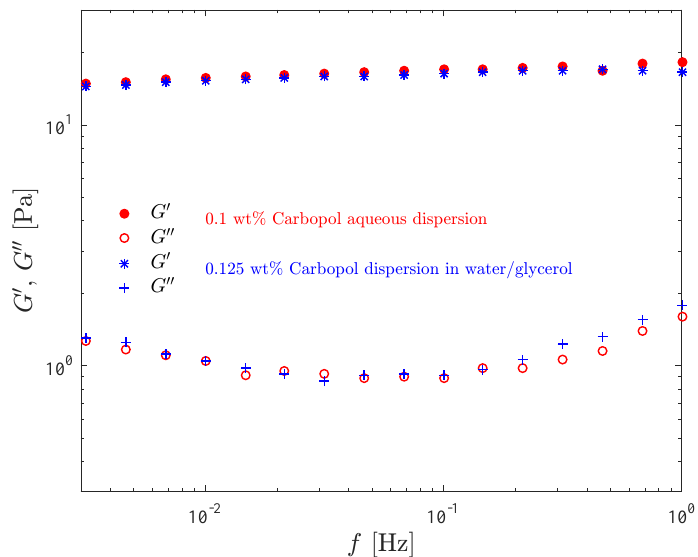
Figure 4. Results of the frequency sweep test for the Carbopol dispersions with the same yield